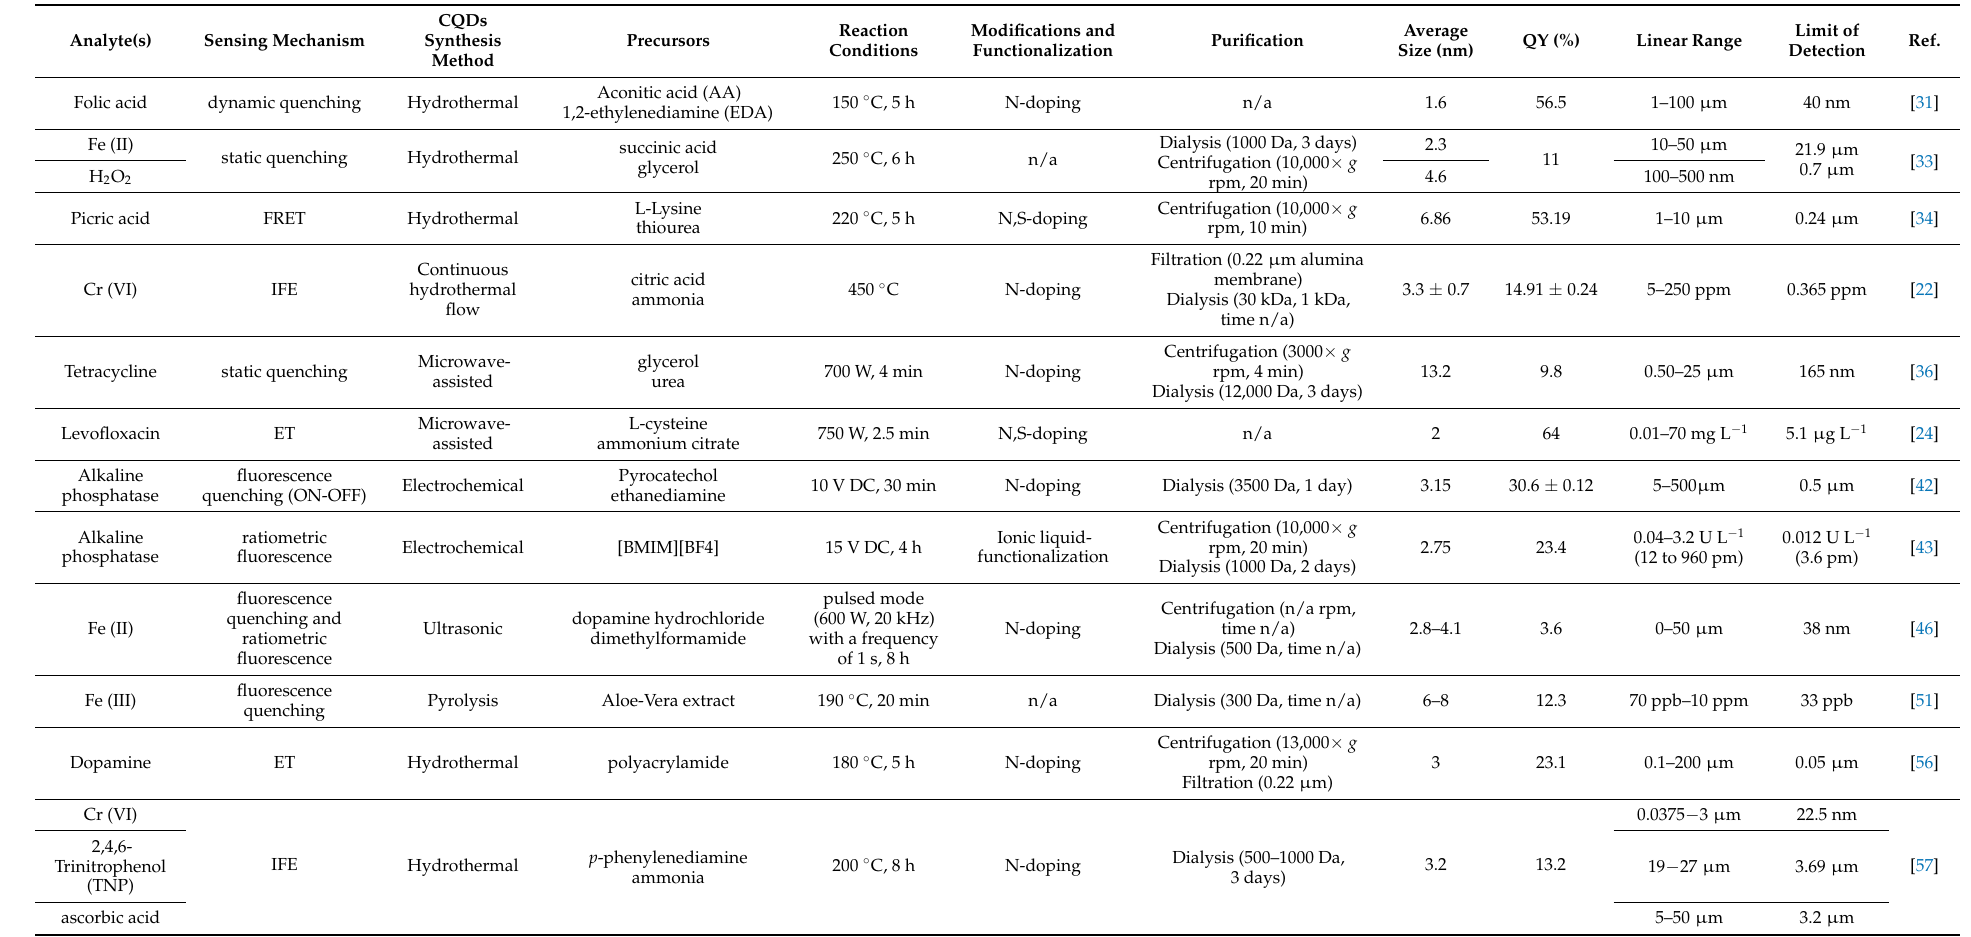
Table 4. Summarized examples of carbon quantum dots used fo0r chemical